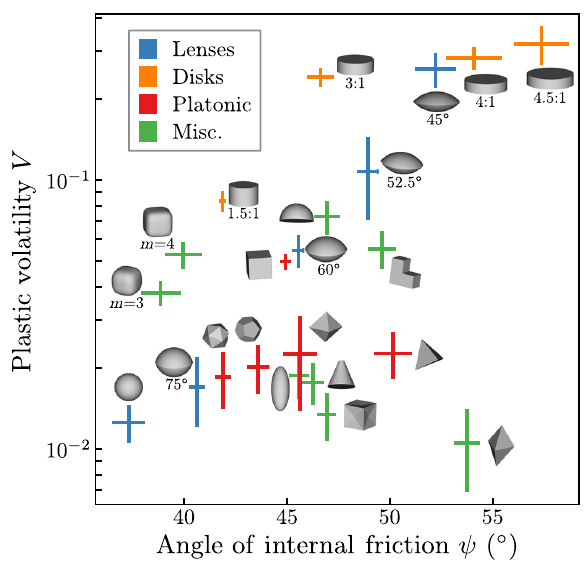
FIG. 3. Plastic deformation phase space. The jerkiness of the plastic regime and the shear strength are mapped out by plotting the annualized plastic volatility V versus the angle of internal friction ψ . Cross bars for each particle shape are the standard deviation of V and ψ across